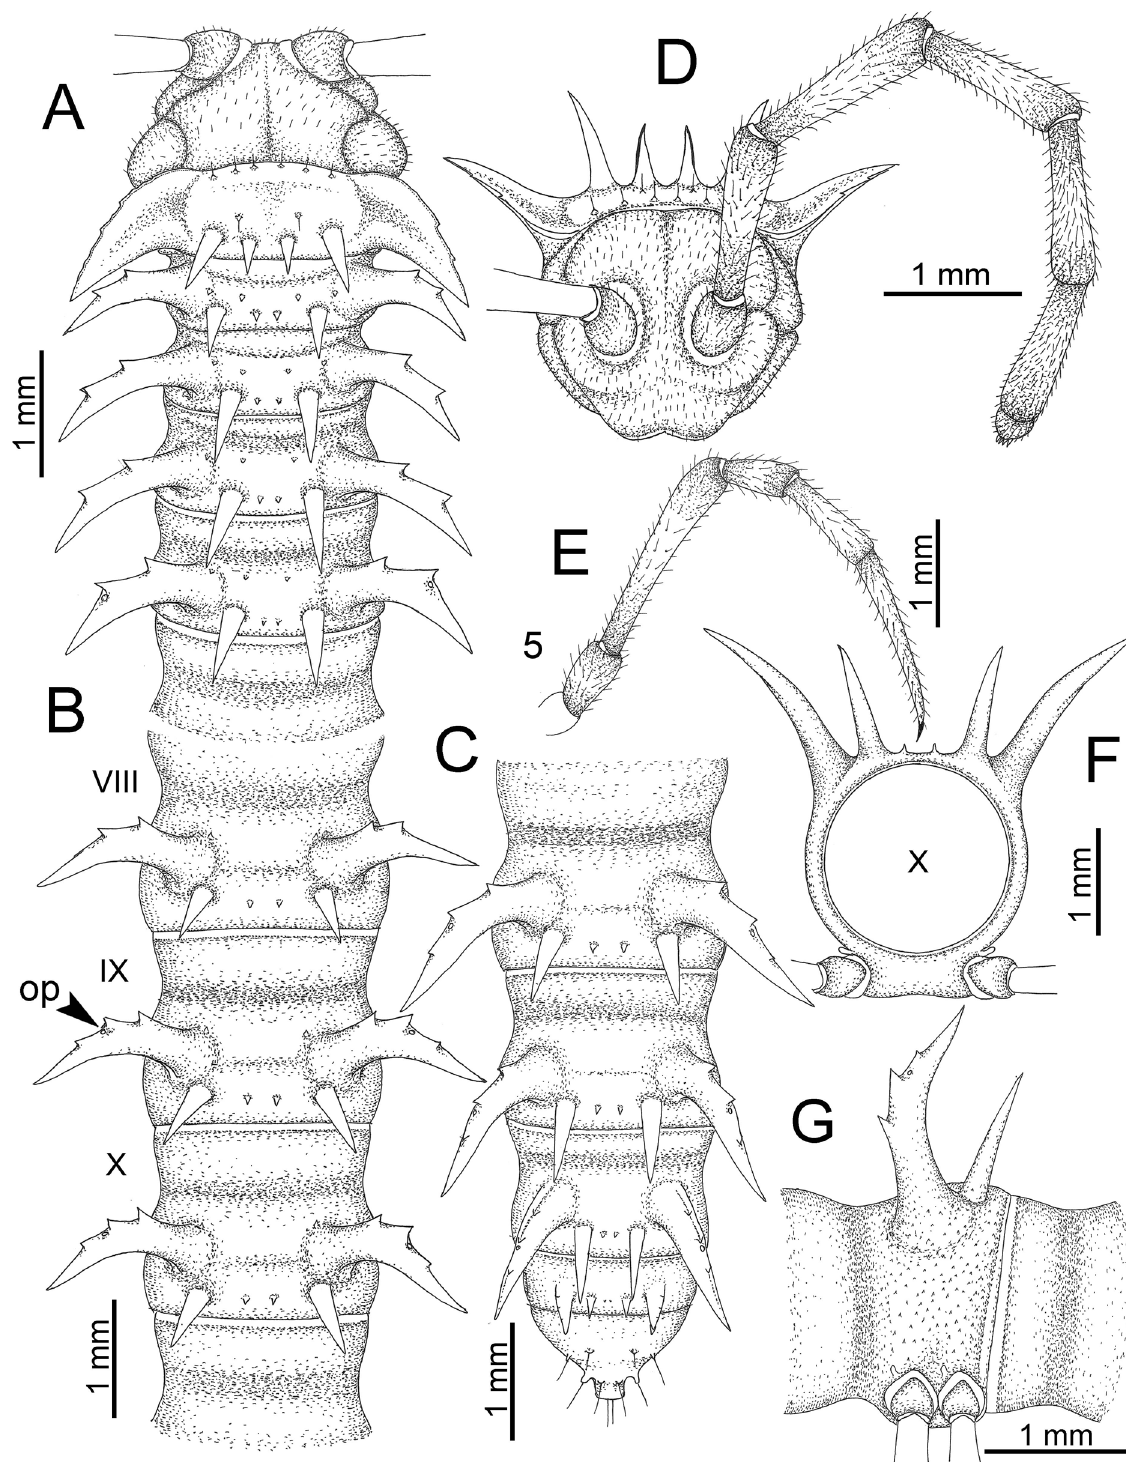
Fig. 23. Nagaxytes spatula Srisonchai, Enghoff & Panha gen. et sp. nov., ♂, paratype (CUMZ- pxDGT00120). A . Anterior body part. B . Body rings 8–10. C . Posteriormost body rings and telson. D . Head and antenna. E . ♂, leg 5 (right). F – G . Midbody